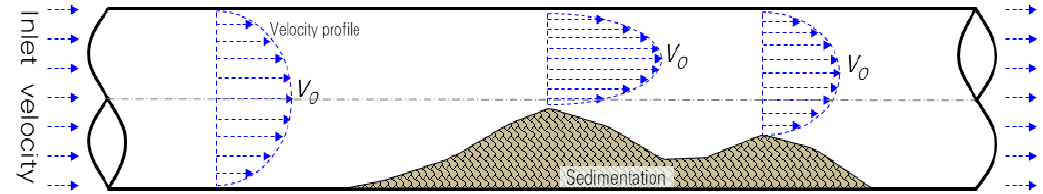
Figure 4. Change of the velocity profile of turbulent flow within a pipe due to sedimentation.